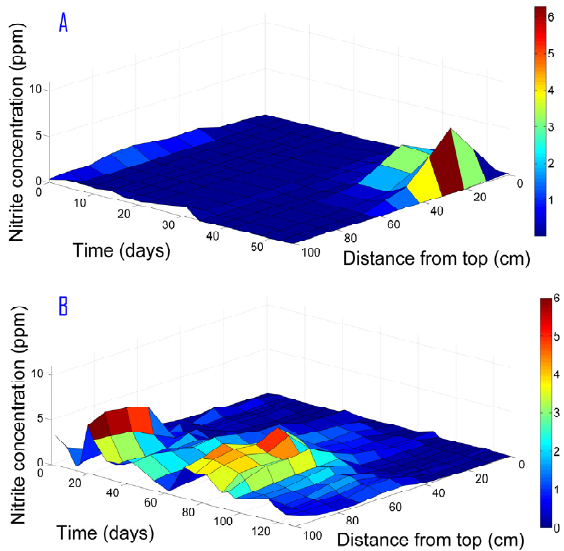
Figure 5. Nitrite concentration as a function of time and distance along the column in ( A ) Phase I and ( B ) Phase II.